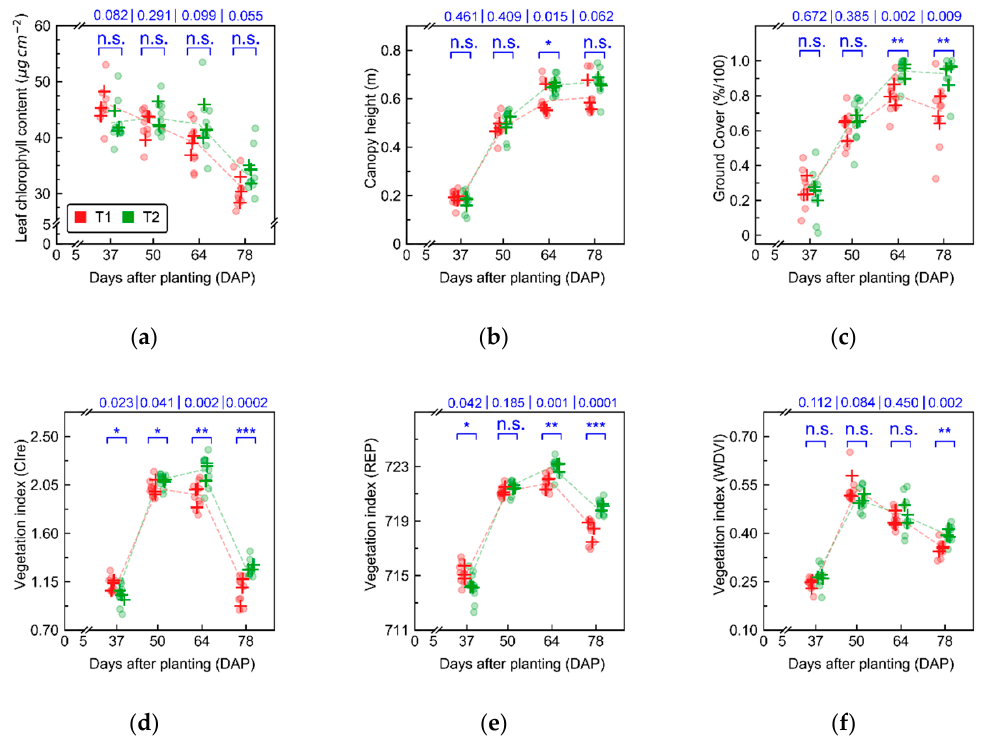
Figure 3. Leaf chlorophyll content ( a ), canopy height ( b ), ground cover ( c ), and vegetation indices (Table A2), namely, CIre (Chlorophyll Index red edge, d ), REP (Red Edge Position, e ), and WDVI (Weighted Difference Vegetation Index, f ) derived from UAV imagery, describing crop growth under different cultivation systems (T1 and T2, “non-mixed” and “mixed” treatments, respectively). Points indicate within plot measurements ( n = 3 sampling units per plot), while each cross represent the average at plot level. Lines connect the average for each treatment over time. Numbers in blue correspond to the p-value for each acquisition date. Asterisks communicate the same p-values, indicating contrasts significant at 0.05 (*), 0.01 (**), and 0.001 (***). Changes on ground cover over time for sampling units (SUs) imaged using ground-based and